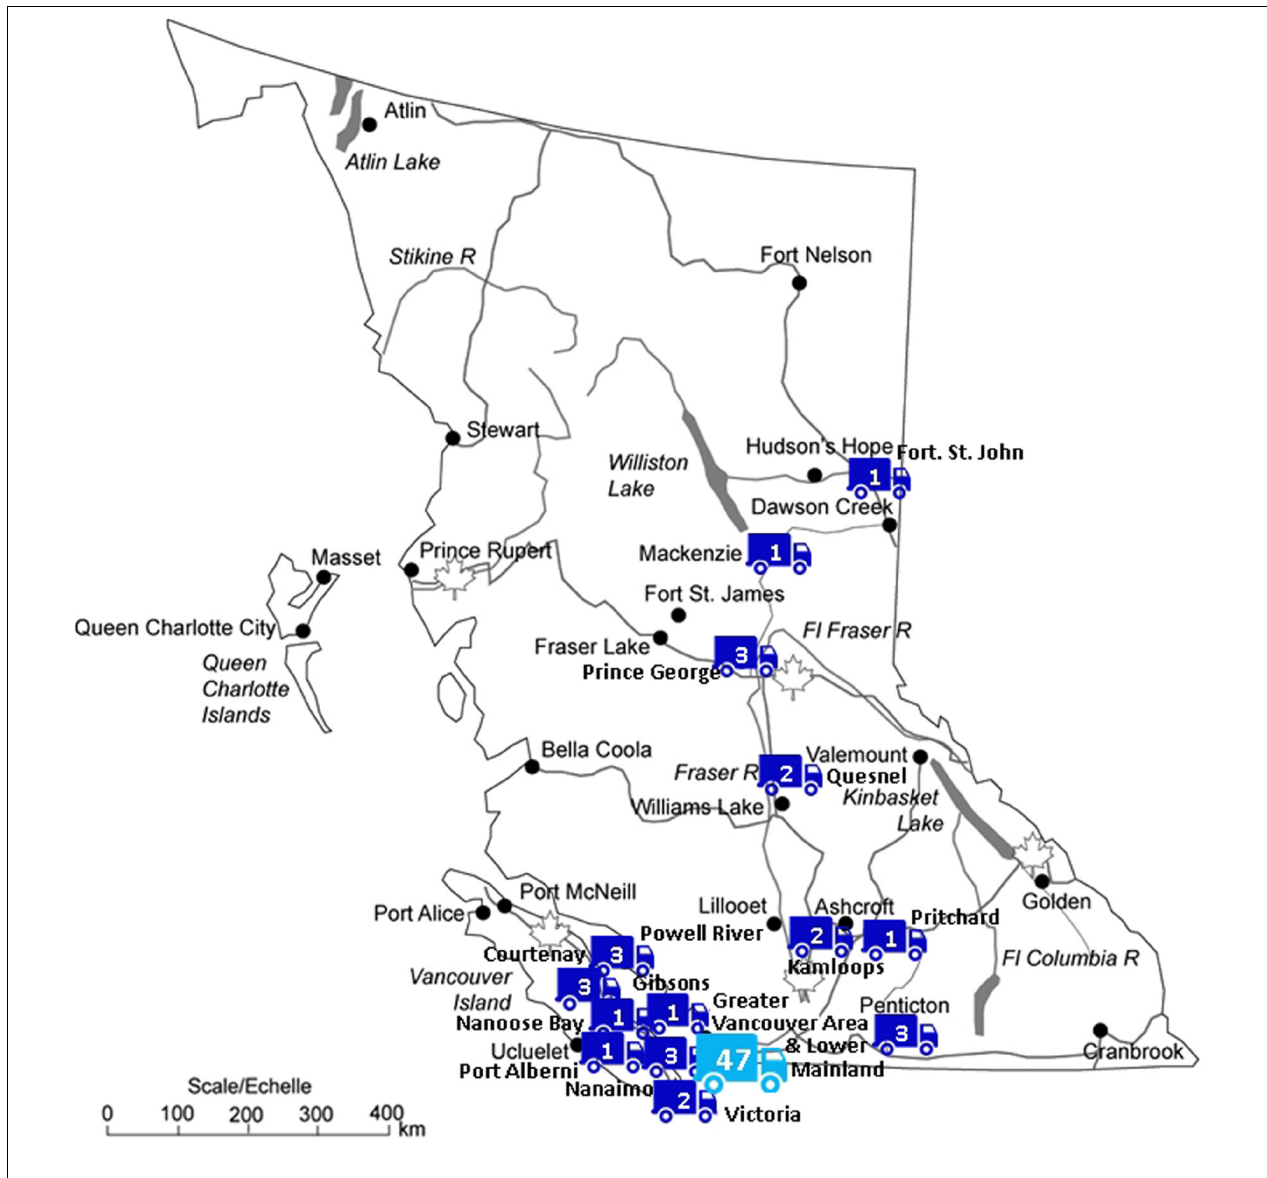
FIGURE 8 | Map of BC with video equipment destinations over the last period of year . This figure shows the distribution and frequency of video equipment destinations throughout British Columbia, Canada. There were 74 deliveries in total over the last year, 47 of which were within the Greater Vancouver Area and Lower Mainland (distributed by municipality as